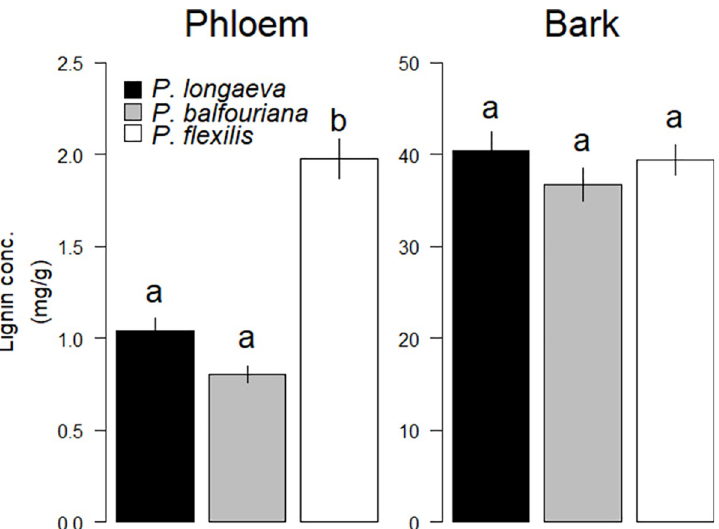
Fig 2. Phloem and bark lignin concentratons ( ± standard error) in P . longaeva , P . balfouriana , and P . flexilis averaged across all sites. Different letters (i.e., a,b) denote statistically significant differences among species means (p < 0.05). See Table 2 for statistics.